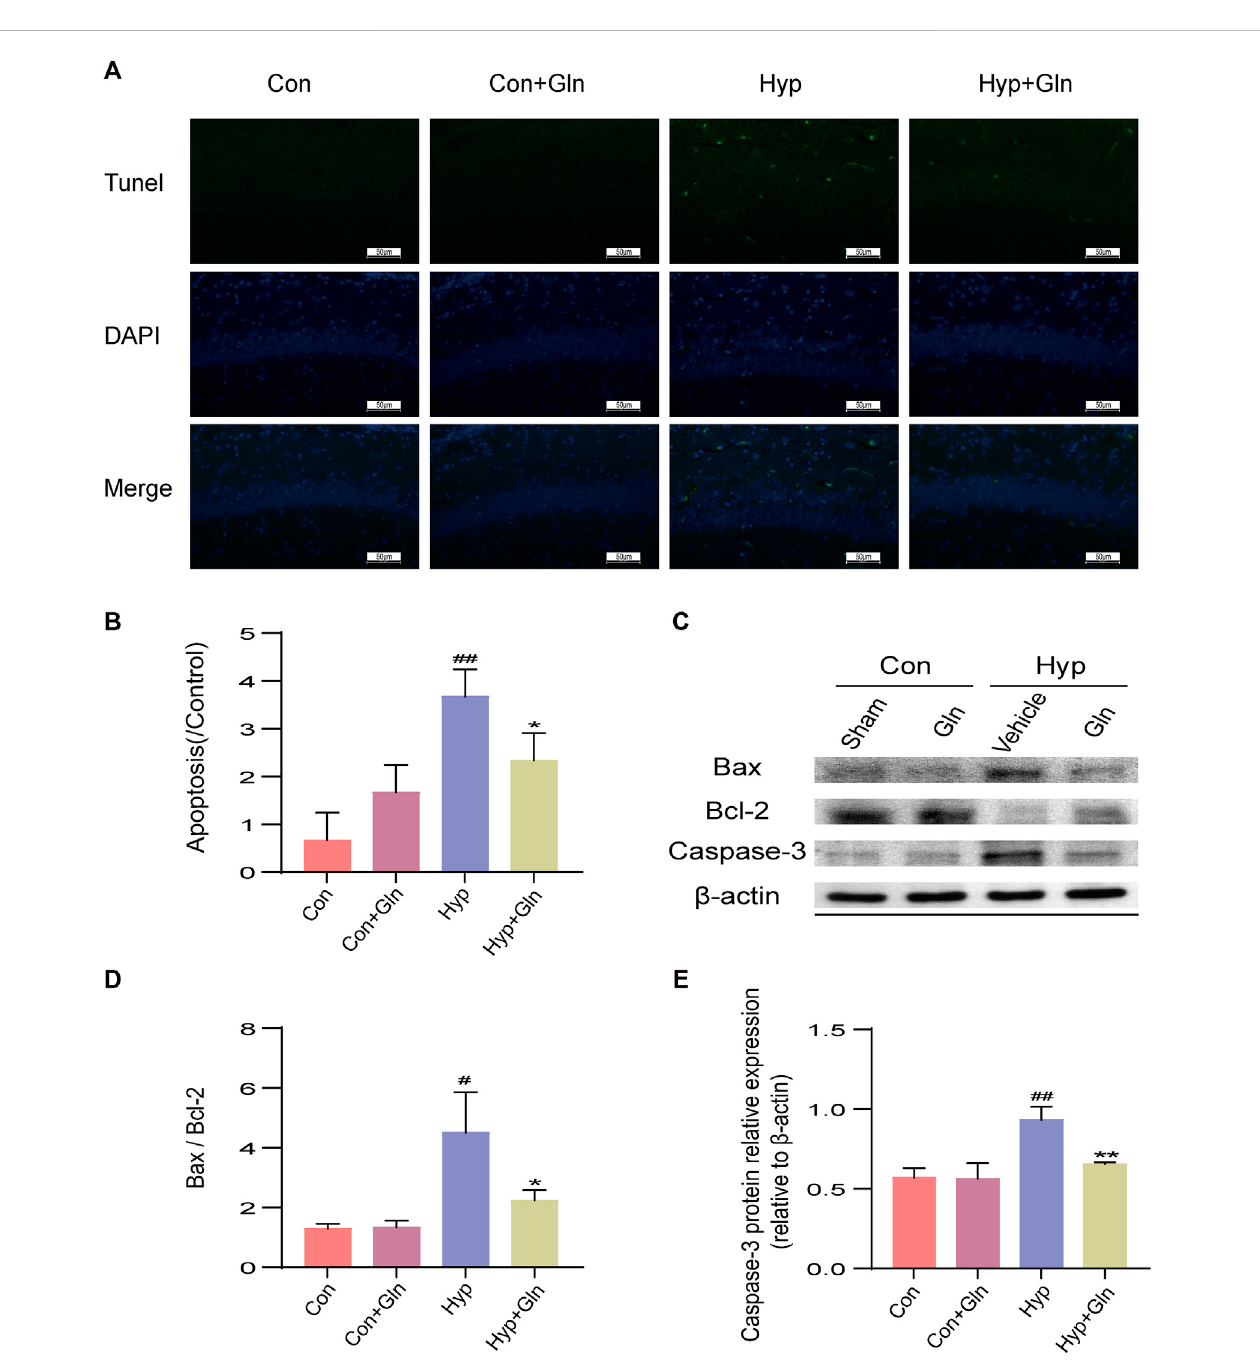
FIGURE 6 Glninhibitsneuronalapoptosisinratswithhyperoxia-inducedbraininjury. (A) TUNELstainingofhippocampaltissue.Scalebar=50 µm (B) Hippocampal Apoptosis Index (AI). Con (0.67 ± 0.33), Con + Gln (1.67 ± 0.33), Hyp (3.67 ± 0.33), Hyp + Gln (2.33 ± 0.33) (C) Representative images of Western blotting analysis of Bax, Bcl-2 and Caspase-3 of each group. (D) Ratio of Bcl-2 to Bax. Con (1.29 ± 0.10), Con + Gln (1.34 ± 0.13), Hyp (4.50 ± 0.79), Hyp + Gln (2.24